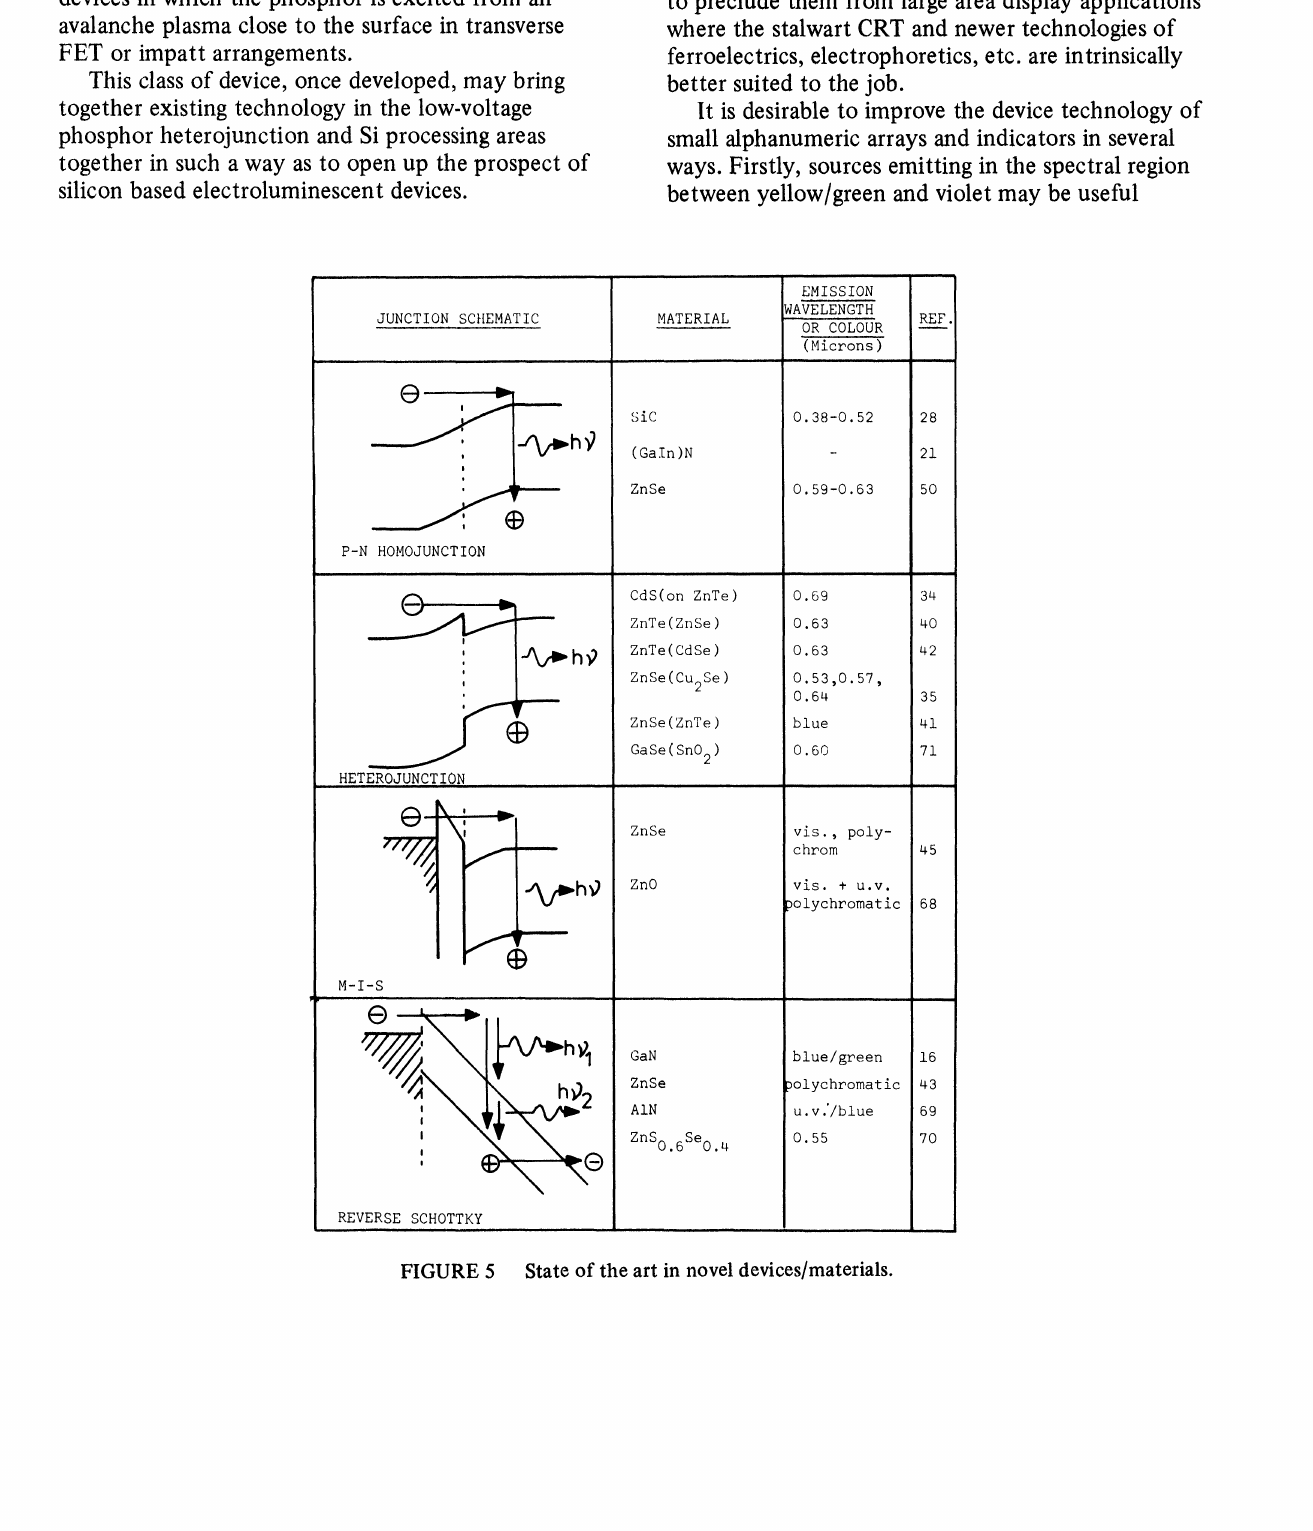
FIGURE 5 State of the art in novel